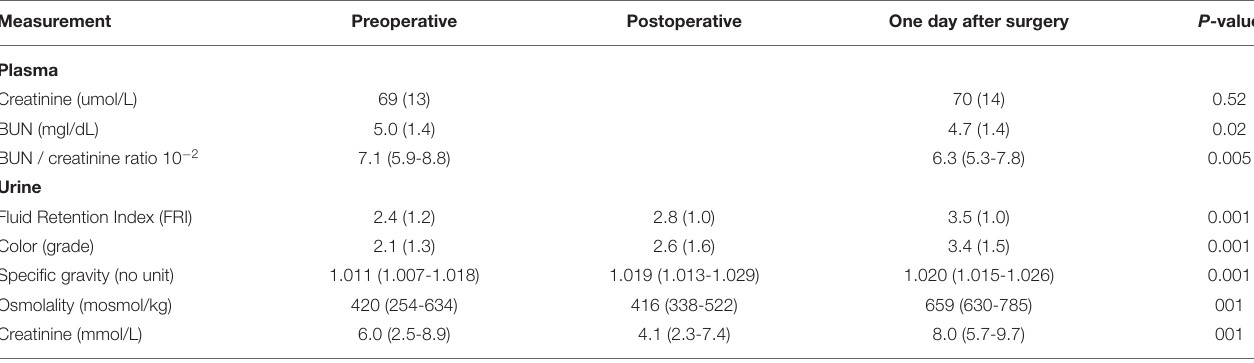
TABLE 4 | Key measurements in plasma and urine that relate to dehydration.